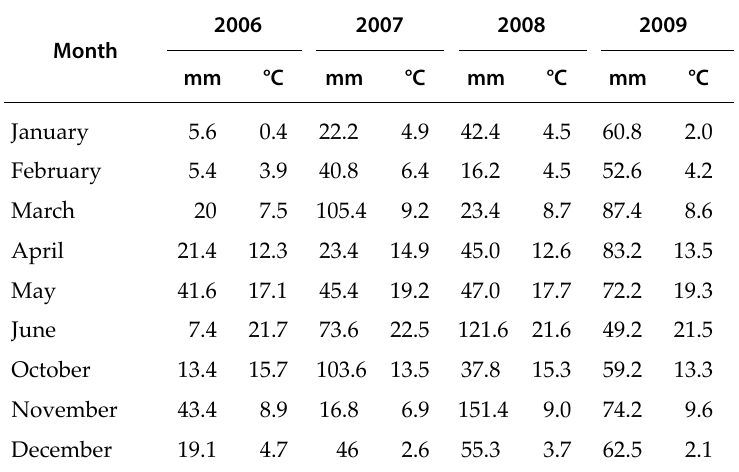
Table 3. Total monthly precipitation (mm) and mean monthly temperature (°C) in the experimental area over the period of